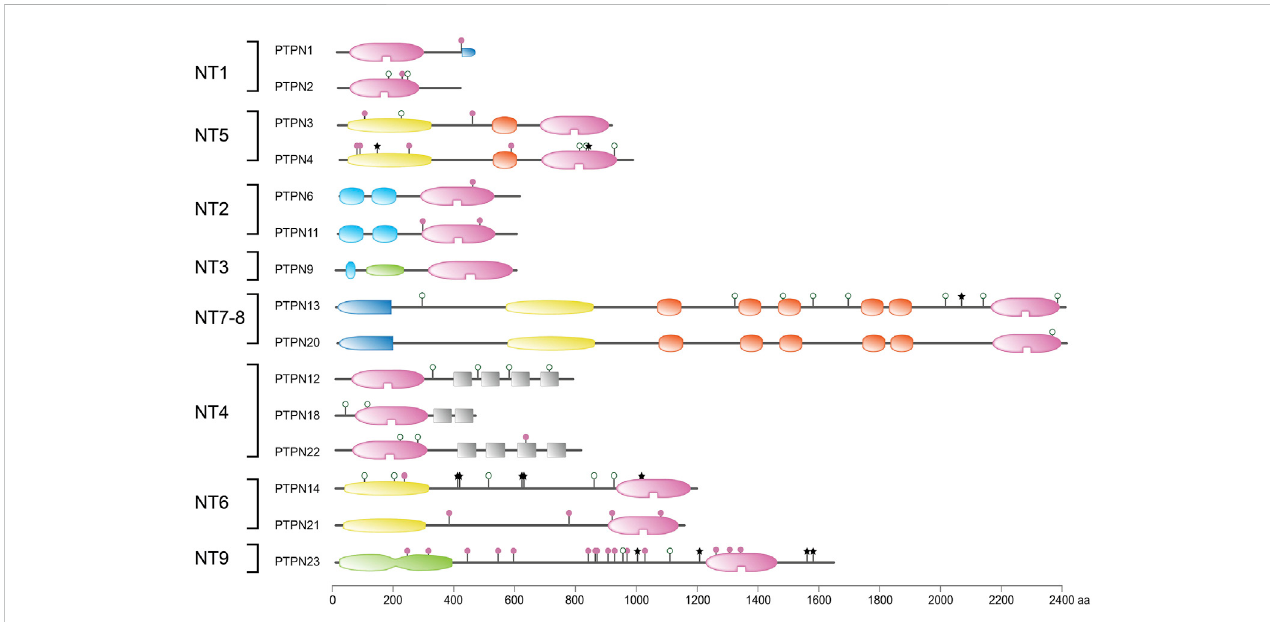
FIGURE 4 Protein sequence variant positions in non-transmembrane PTPs found in literature or arising from a common SNP. Classi fi cation (left) and protein domain structure build-up (right) of the ‘ NT ’ subclass of PTPs are as in Figure 1. PTPN5 and PTPN7 are not depicted here; they form part of the receptor-type subgroupR7.Sequencevariantsarerepresentedbylollipopsonthestructuralcartoons.Thereddishpurplelollipopsrepresentnon-synonymousmutantsthat are discussed in the text. The black star lollipops re fl ect frame-shift and non-sense variants discussed in the text. Lollipops with green open circles represent nonsynonymous variants occurring in > 1% of the population and have not been linked to phenotypic consequences in the literature. All variant positions and linked corresponding literature references are included in Supplementary Table S1. The horizontal bar at the bottom indicates protein